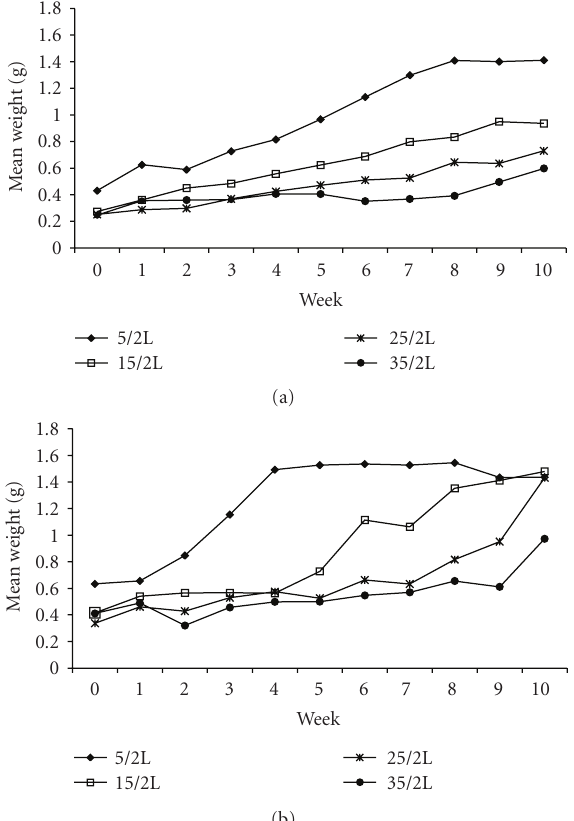
Figure 2: Mean weight per unexposed (a) and exposed snails (b) over ten weeks. Values for mean weight per snail refer to the average weights of all snails in each treatment group. No significant variation between tanks in each treatment group was